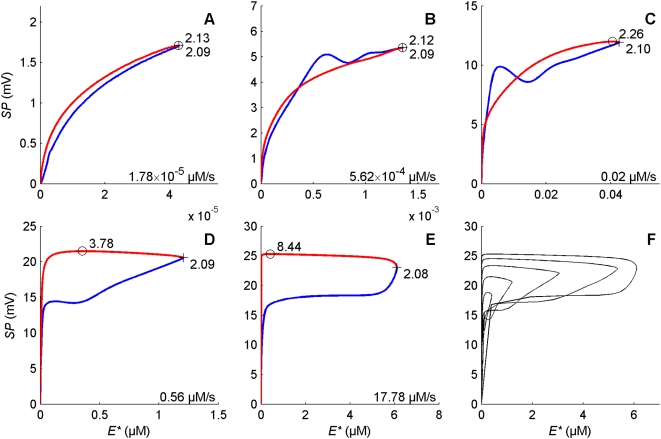
Phase portrait on the E*-SP plane at different pheromone uptakes.(A) 1.78×10−5, (B) 5.62×10−4, (C) 0.02, (D) 0.56 and (E) 17.78 µM/s. (F) Superimposition of the phase portraits. The starting point at t = 0 is close to the origin (0, 0). Same representation as in Figure 12.